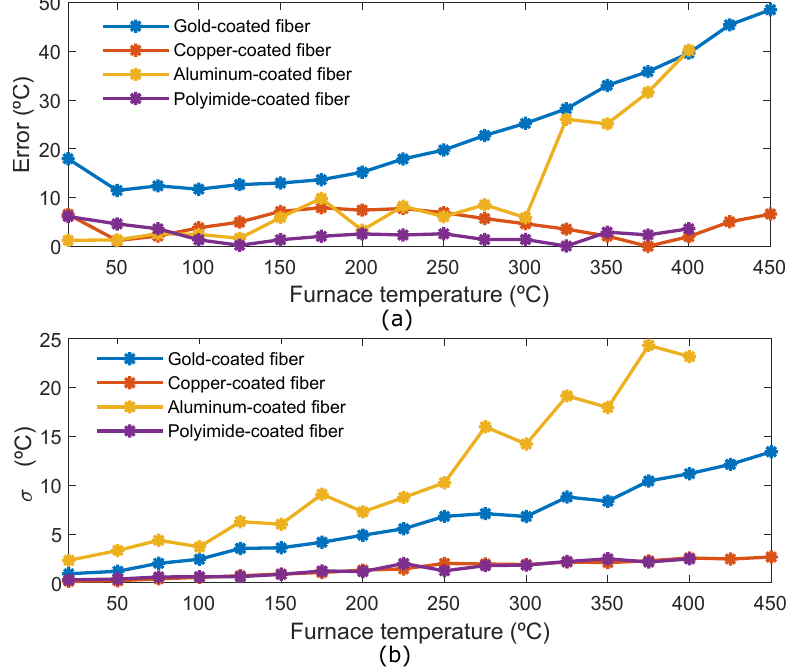
Figure 6. ( a ) Mean error of the hot-spot section for the four fibers; ( b ) Variance ( σ ) of the hot-spot section for the four